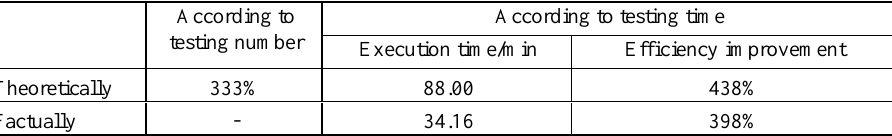
Table 1. Efficiency improvement of applying grey-box